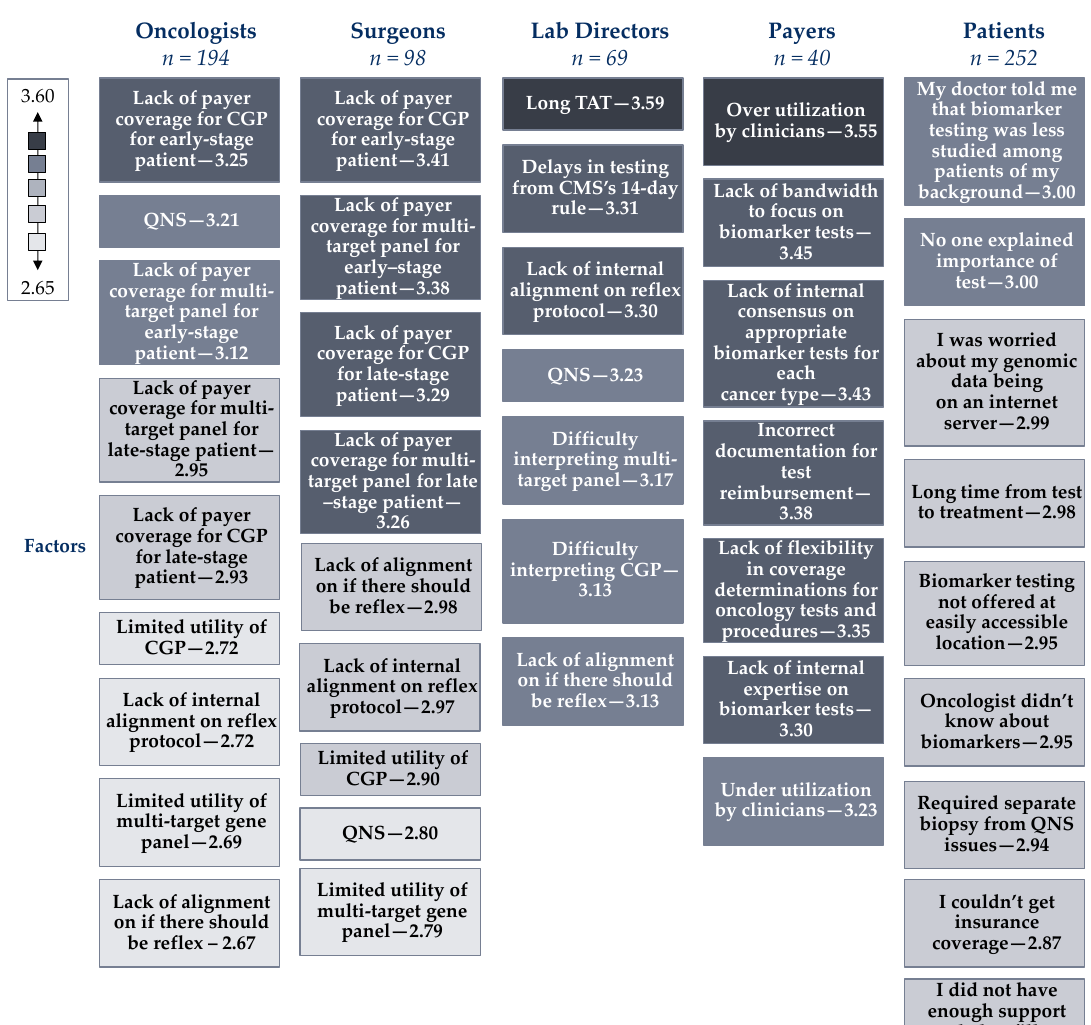
Figure 2. Lab directors, oncologists, surgeons, payers, and patients ( n = 653) were asked the following question with different responses. Please rate how challenging the following factors are to biomarker testing for oncology targeted therapies on a scale of 1 to 5, where 1 is not challenging and 5 is very challenging. Responses are listed in order of largest to smallest challenge and shaded grey based on the legend from 2.60–3.60. Note: QNS = Quantity Not Sufficient defined as not enough specimen for a laboratory to perform the requested tests. TAT = Turn-around-time defined as the time taken from specimen collection to laboratory test results being reported. CMS = Centers for Medicare and Medicaid Services. CMS’s 14-day rule requires a clinical laboratory to seek reimbursement for testing ordered within 14 days of patients